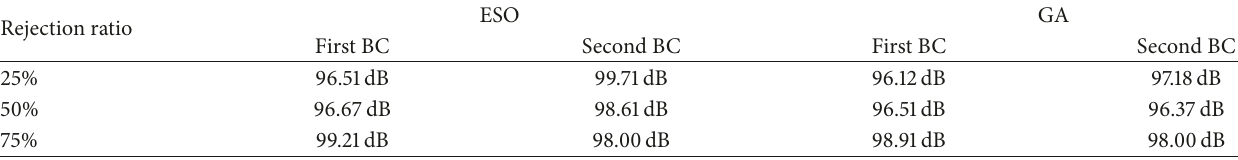
Table 2: Minimum sound power obtained using of ESO and GA (dB).